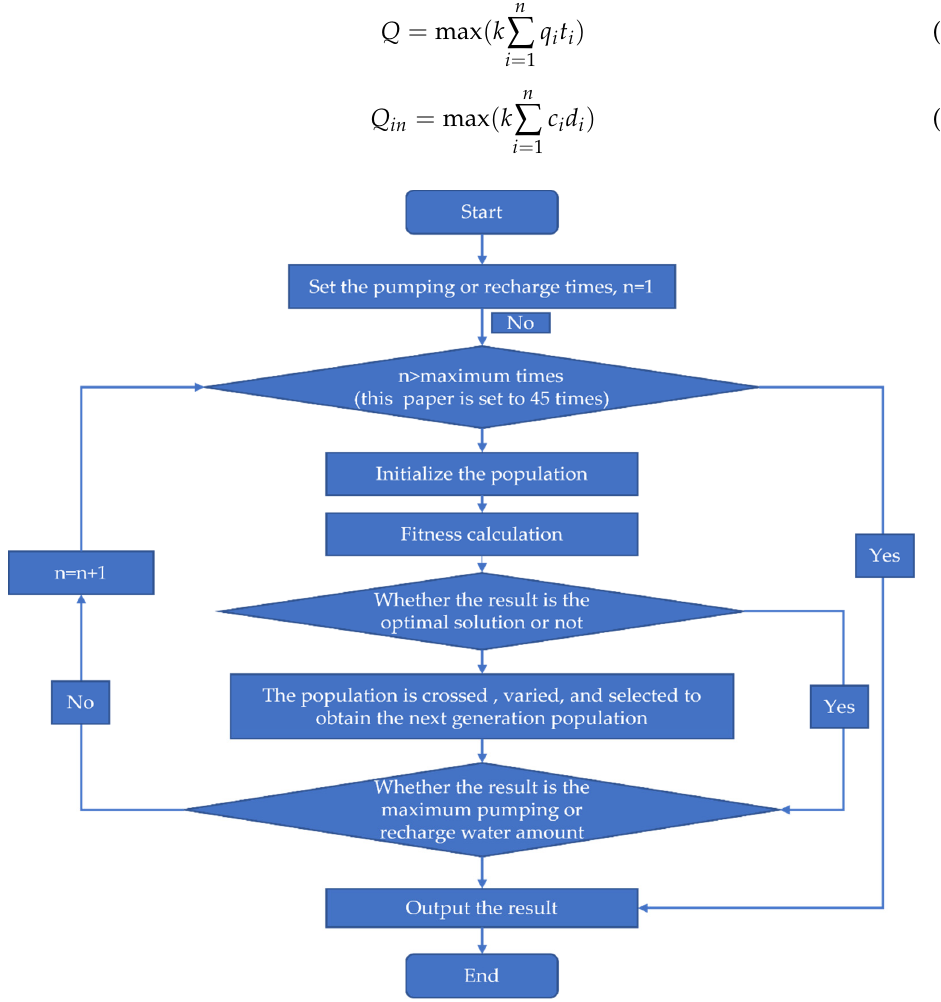
Figure 15. Genetic algorithm computational flow.